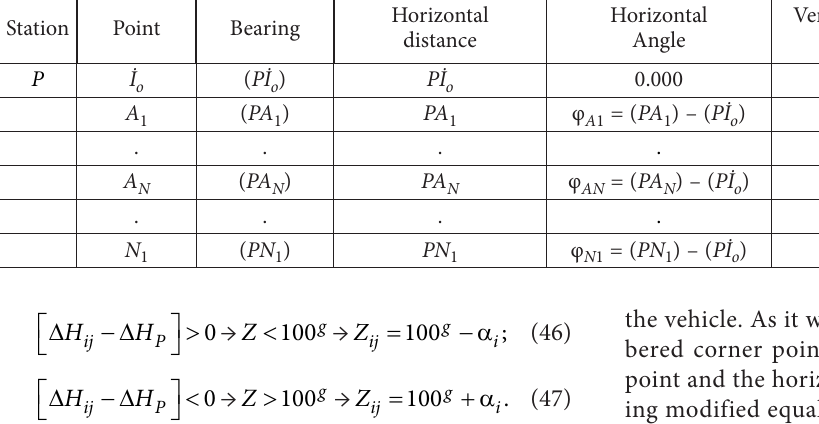
Table 1. The application elements of curve intermediate elements to applicate from P station points in the digital project model by polar method